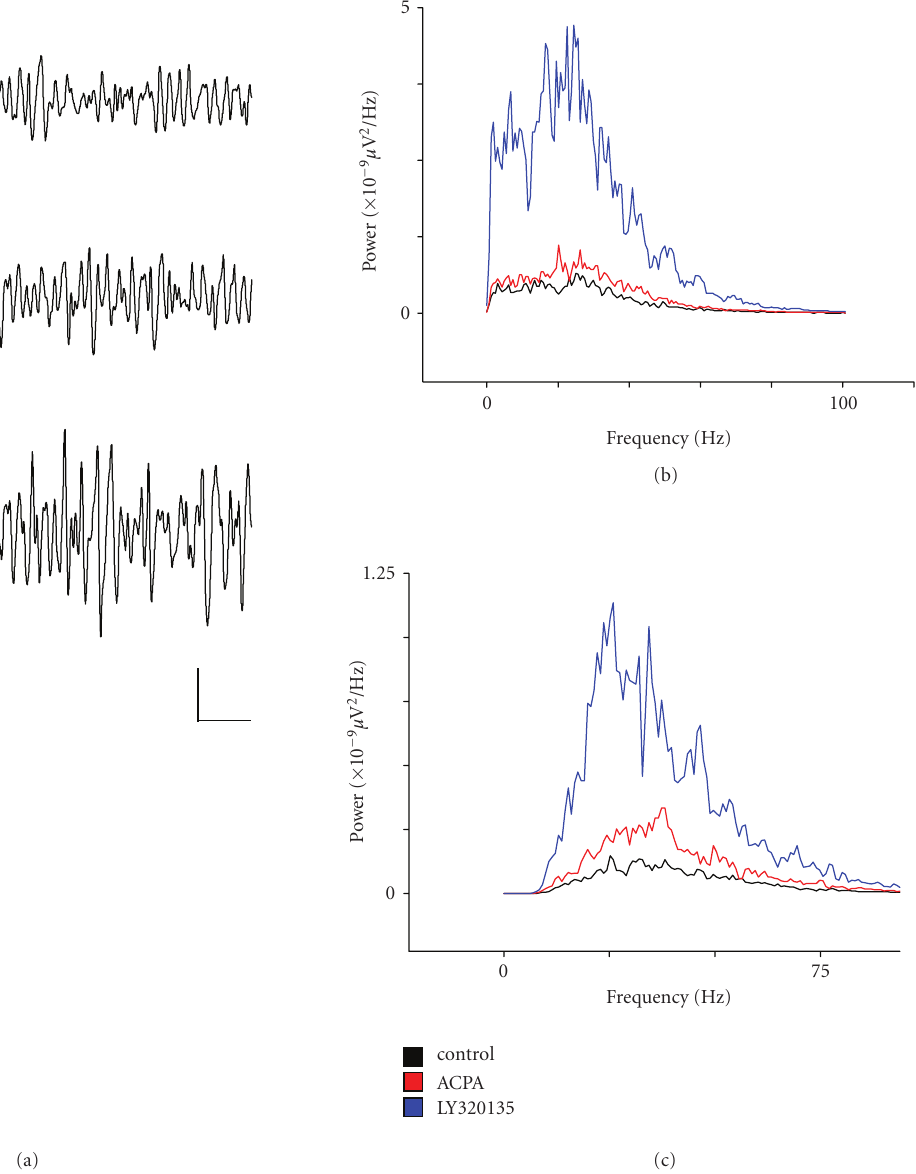
Figure 3: The e ff ects of ACPA and LY320135 on γ -band activity in mEC layer V. (a) Example traces from layer V showing γ -oscillations under conditions in which ACPA (10 μ M) or LY320135 (500nM) was applied. (b) Plot of power spectral density during drug application (filtered between 2–100 Hz). Control (black line), ACPA (red line), or LY320135 (blue line). (c) Similar plot to (b) bandpass filtered between 30–90 Hz. Scale bar = 200 milliseconds × 50 μ